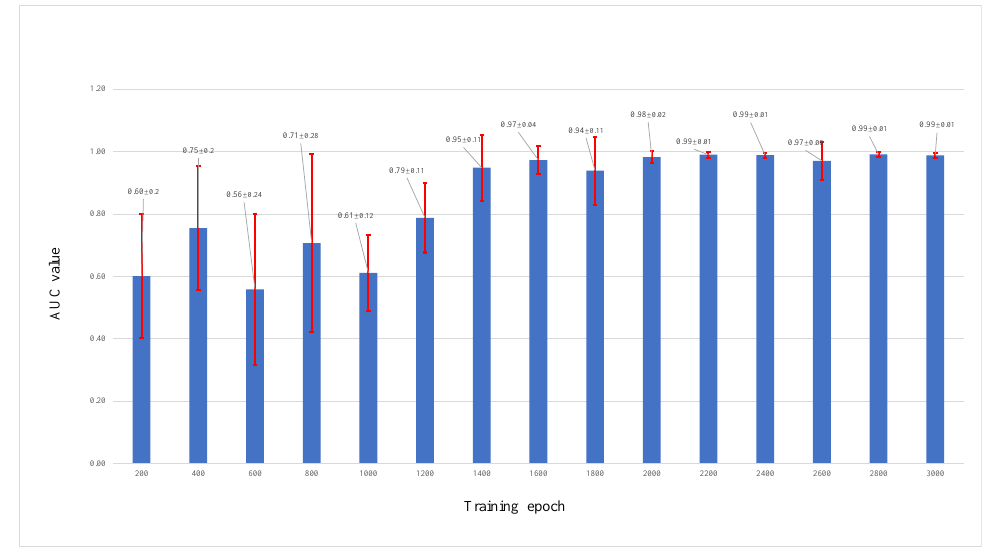
Figure 11. Different AUC values of trained models saved at different training epochs, the red line shows the range of standard err. Table 8. The comparison of test results on two networks generated by different R value.